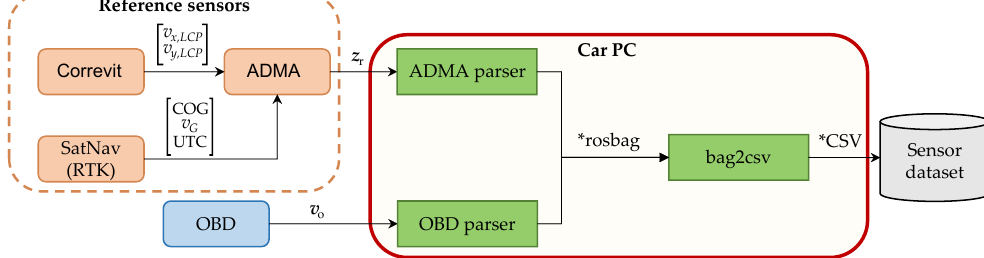
Figure 3. Methodology for data